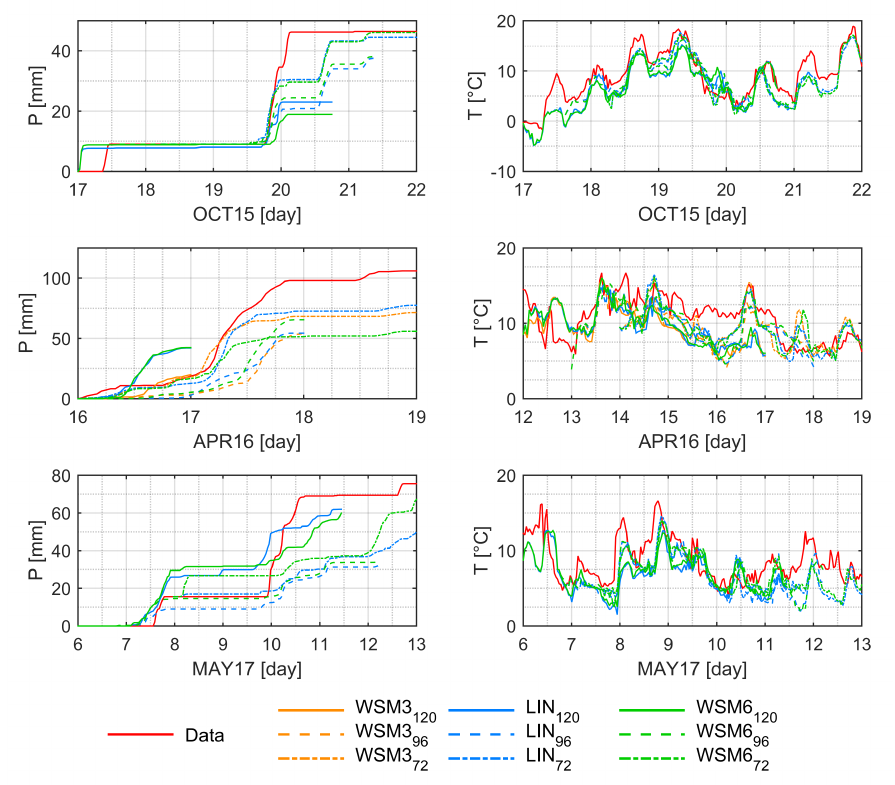
Figure 5. Observed and simulated precipitation ( left ) and temperature ( right ) time series for OCT15 ( upper row), APR16 ( central row) and MAY17 ( lower row) events. Three lead times (72, 96 and 120 h) and three MP parameterizations (LIN, WSM6 and WSM3 when used) are considered. Graphical modifications to the rainfall time series are indicated in the previous